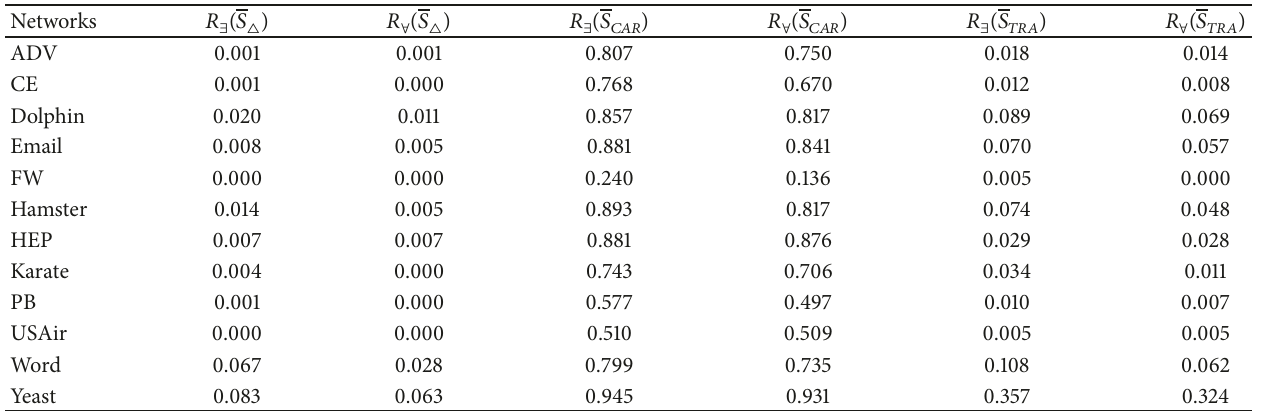
Table 2: The ratios of various seed pairs over the 12